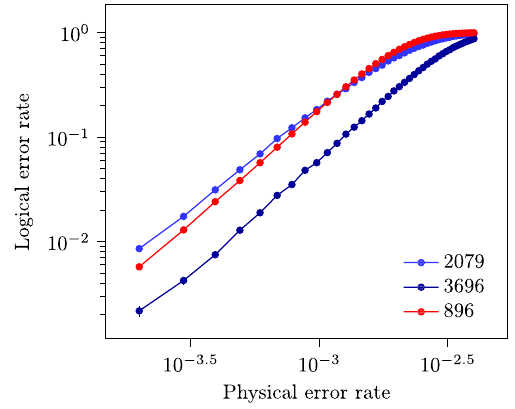
FIG. 32. Performance of a [[384,66,4]] f 8 ; 4 g subsystem hyperbolic code (red) compared to the L ¼ 3 and L ¼ 4 sub- system toric codes (shades of blue) using a ð ZX Þ 10 schedule with the circuit-level depolarizing error model. We use 33 independent copies of the subsystem toric codes to fix the number of logical qubits at k ¼ 66 . In the legend, we give the number of physical qubits used, including